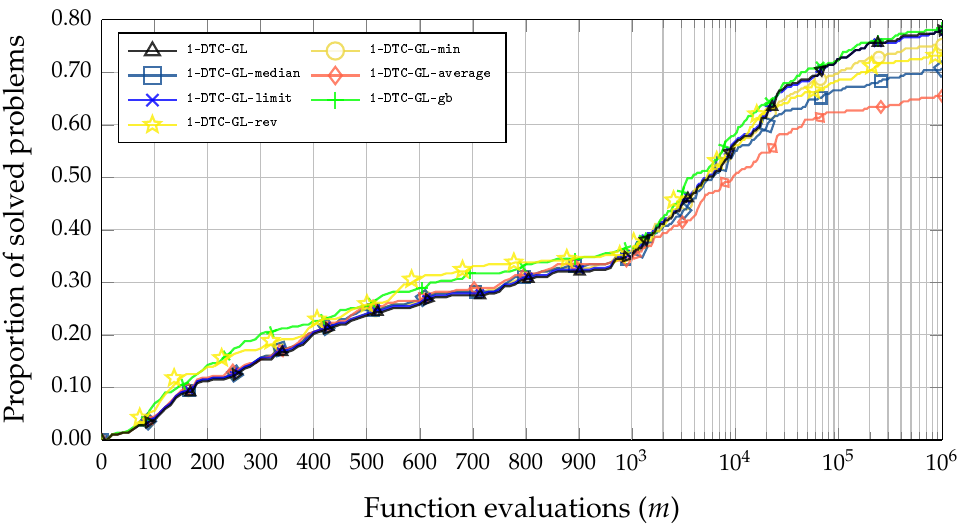
Figure 4. Operational characteristics based on the number of function evaluations for all seven 1-DTC-GL algorithmic variations on the whole set of DIRECTGOLib v1.2 test problems.